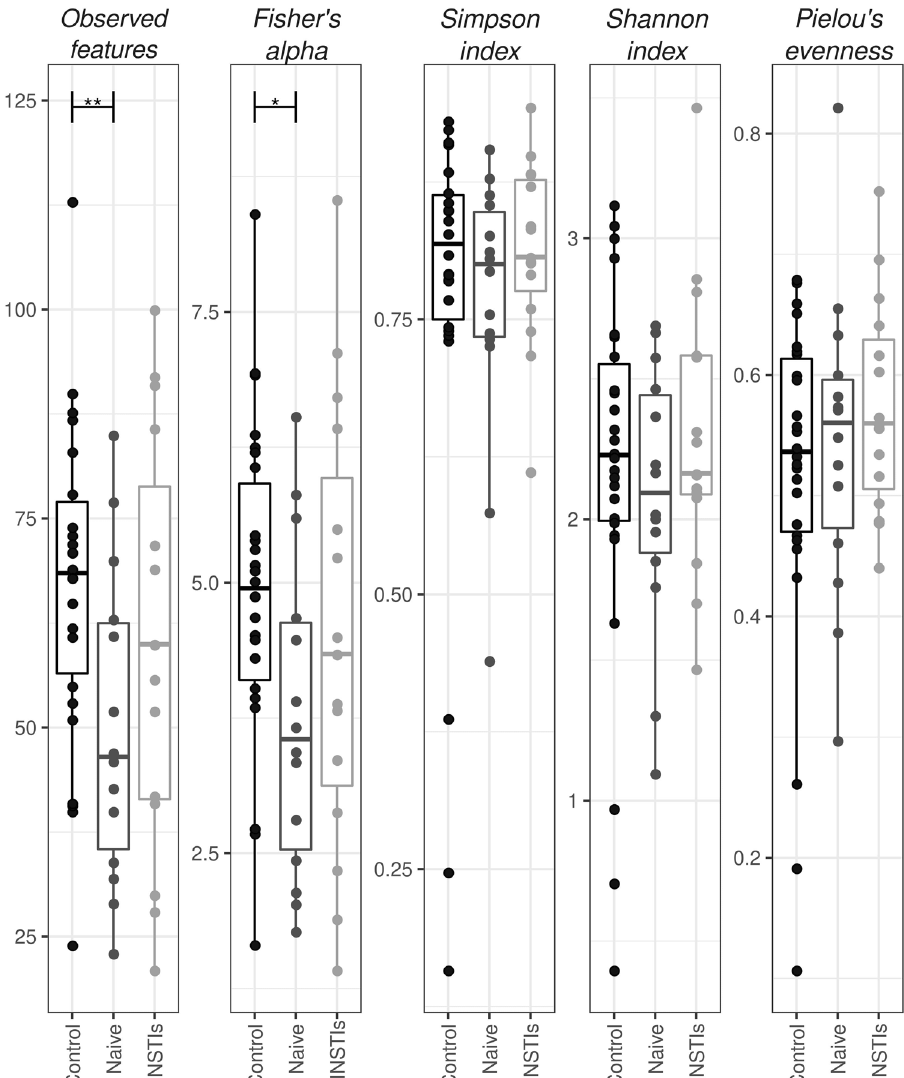
Figure 2. Different indexes of α-diversity from phages in faecal samples of the studied population. *p < 0.05 vs. control, **p < 0.01 vs . control. INSTIs (integrase strand transfer inhibitors-based